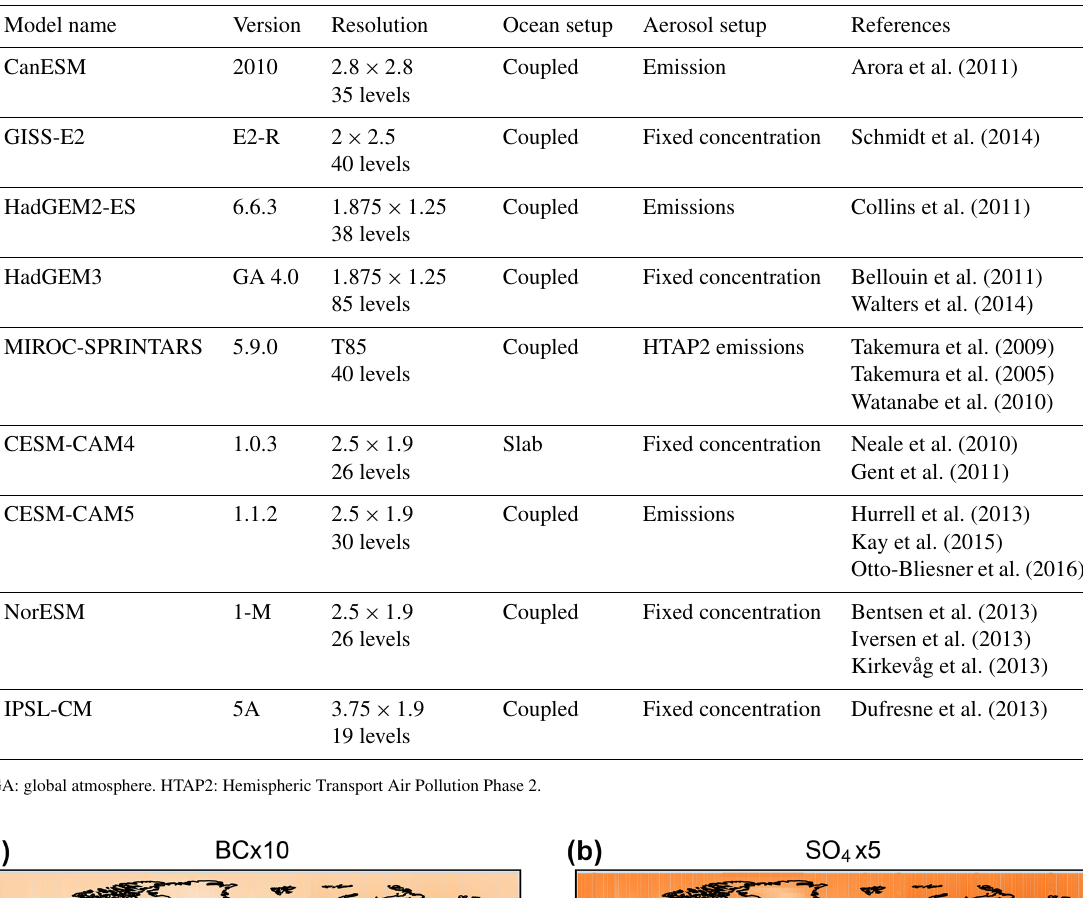
Table 1. Descriptions of the nine PDRMIP models used in this study, adapted from Tang et al. (2019).